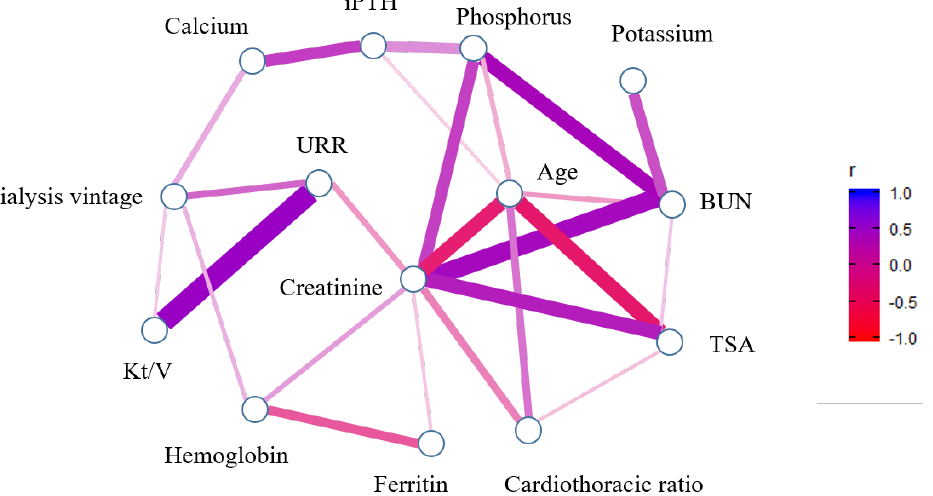
Figure 3. The correlation network between clinical factors. The significant correlations between clinical factors are connected by lines. The thicker and thinner lines represent the higher and lower correlations between clinical factors. The blue and red colors are the positive and negative correlations, respectively.